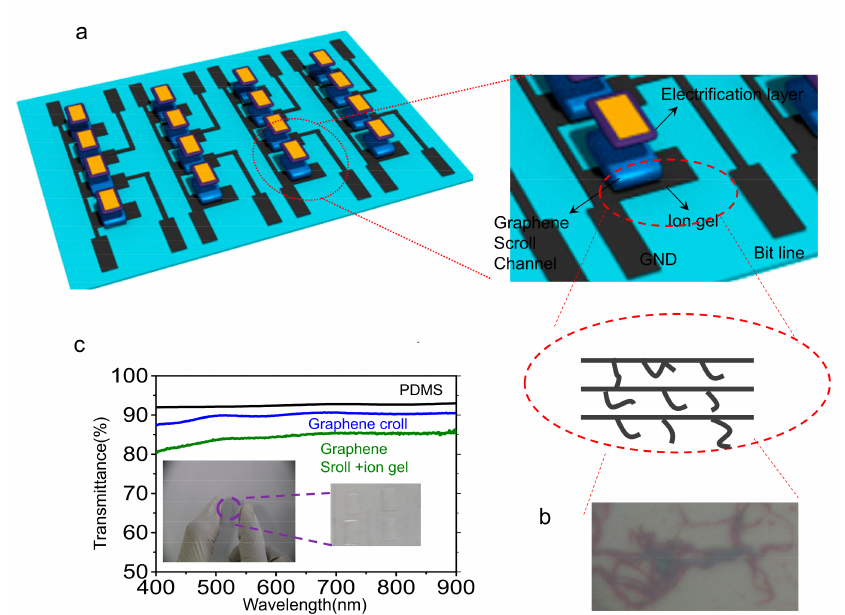
Figure 1. ( a ) Schematic illustration of the noncontact mechanosensation active matrix based on the tribotronic planar graphene transistors array. Inset is the zoomed-in schematic diagram of the single sensing unit. ( b ) Structure and microscopy image of the trilayer graphene scrolls. ( c ) UV- vis transmittance spectrum of PDMS, trilayer graphene scrolls on PDMS, and GSFET on PDMS, respectively. Inset is the photo image of transparent trilayer graphene